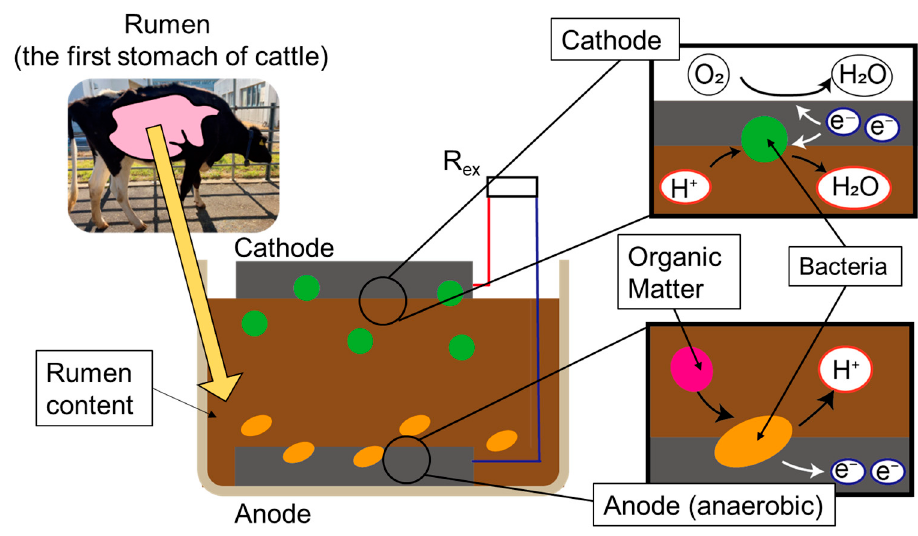
Figure 1. Image of the rumen bacteria MFC.